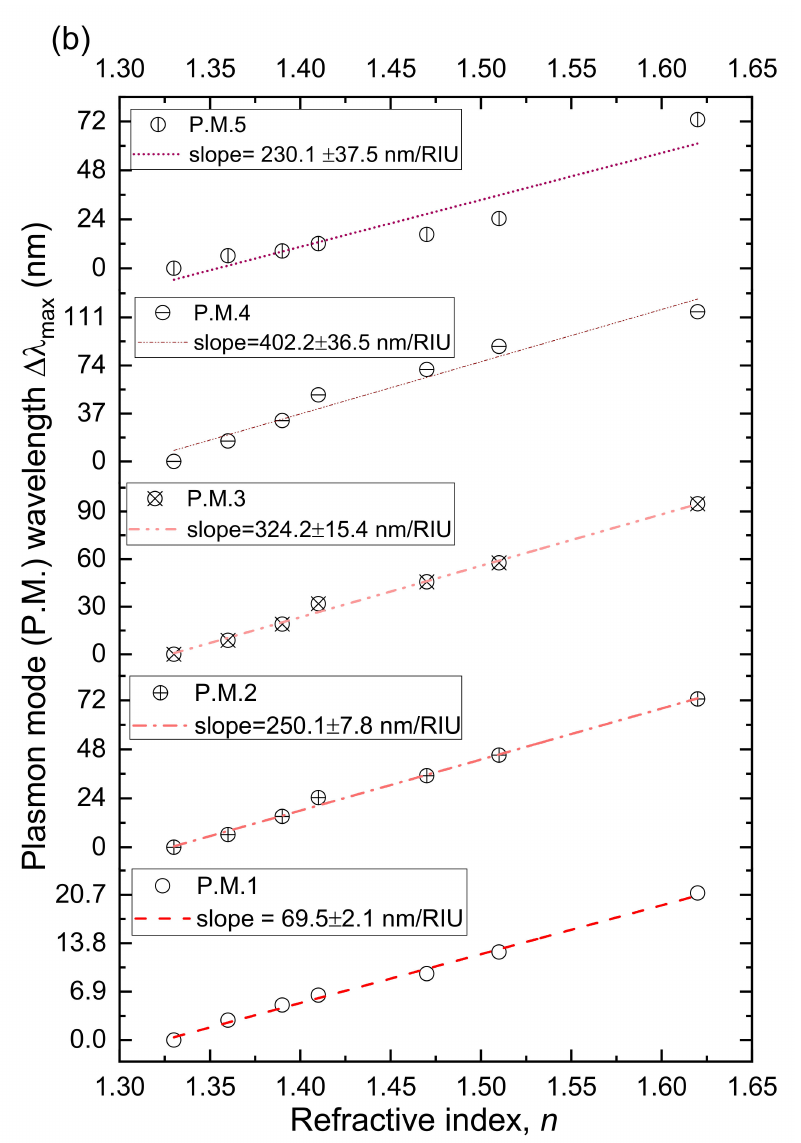
Figure 5. ( a ) Absorption cross section of the heterogeneous nanoantenna at variable wavelength for different refractive index of the surrounding solvents (n 1 = 1.33, n 2 = 1.36, n 3 = 1.39, n 4 = 1.41, n 5 = 1.47, n 6 = 1.51 and n 7 = 1.62). ( b ) Resonant plasmon mode of LSPR variation ∆ λ max for